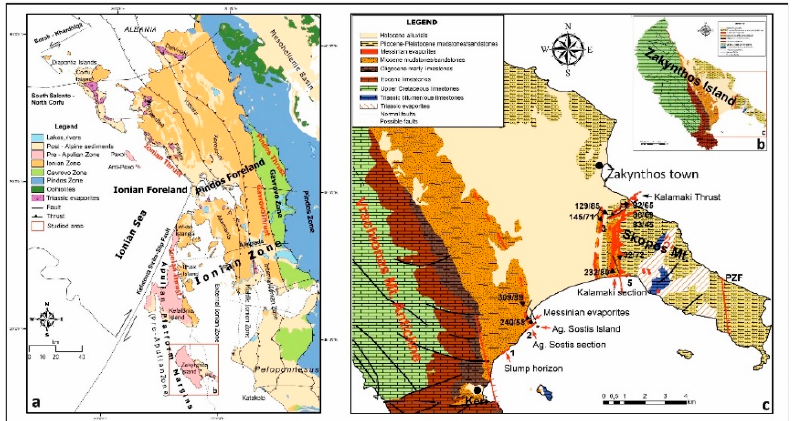
Figure 1. ( a ) Geological map of western Greece, where the characteristic Ionian thrust and Ionian foreland are marked, respectively. Red box shows Figure 1b of the Zakynthos Island. ( b ) The geological map of Zakynthos Island. Red box shows the location of the studied area of Figure 1c. ( c ) Detailed geological map of the studied area where bed direction and angle of inclination are marked. Moreover, studied sections and studied places are marked.